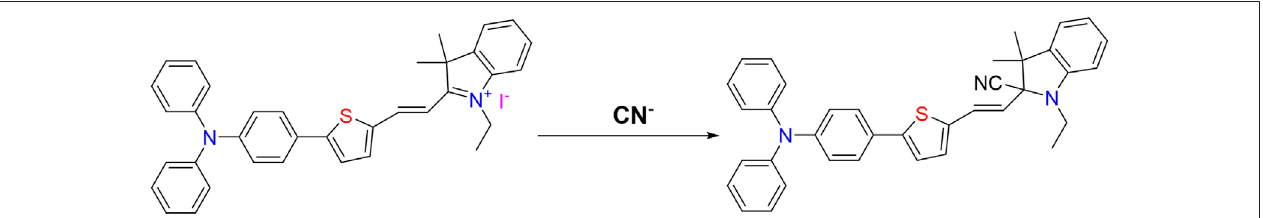
FIGURE 10 | Proposed sensing mechanism of probe W for CN − .